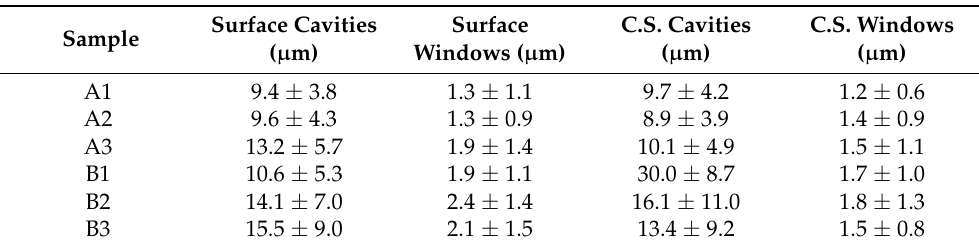
Figure 4. SEM pictures of the surface morphology (S) and the cross-section morphology (C.S.). The scale bar represents 20 µ m. Table 4. Cavity and window diameter of the surface and cross-section of trithiol- and tetrathiol-based